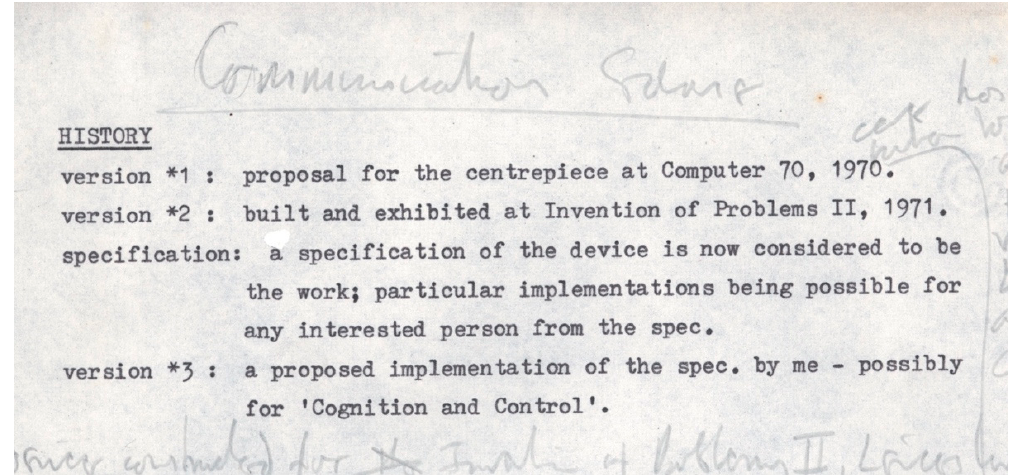
Figure 4. Sketch of Communications Game version 2 (c. 1972). © Ernest Edmonds.